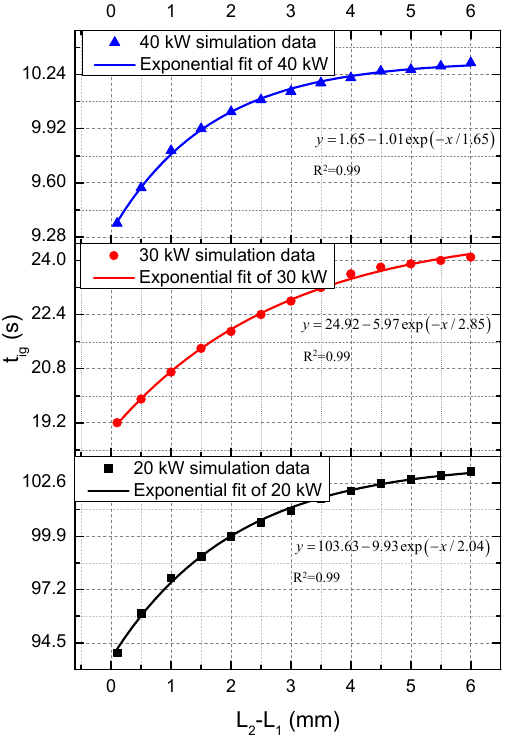
Figure 10. Influence of cable core thickness on ignition time.